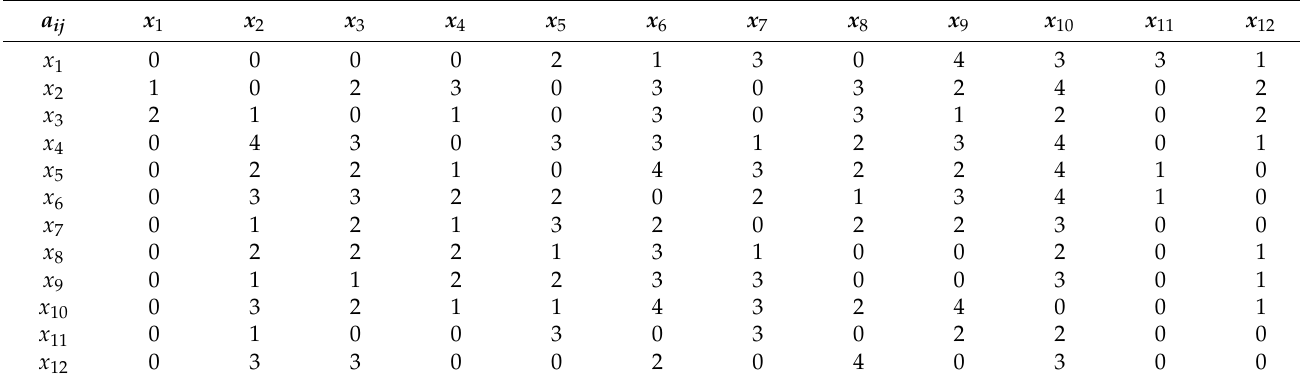
Table 2. Direct influence matrix A .